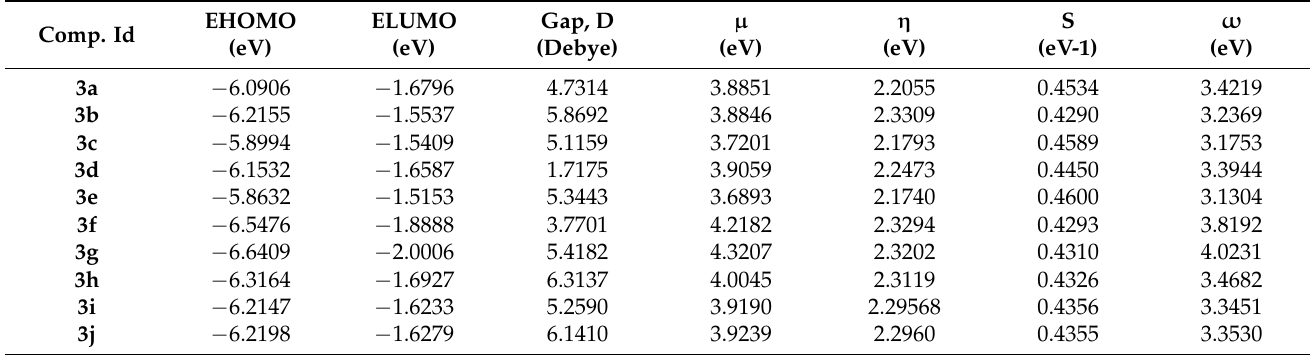
Table 2. Calculated quantum chemical descriptors.